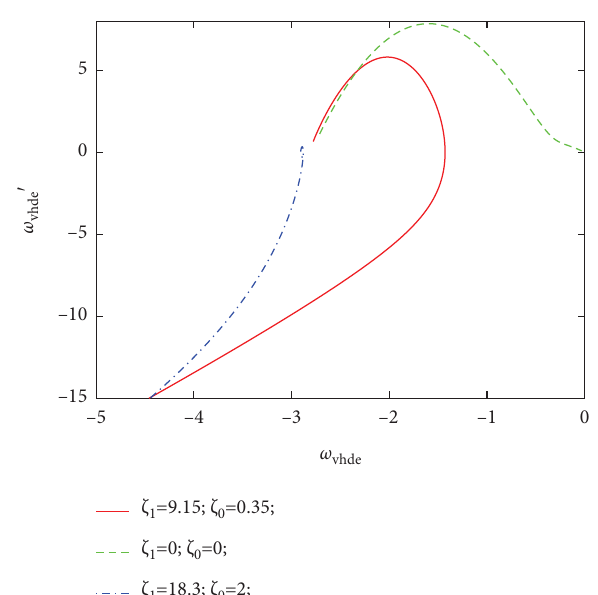
− ω ) for vhde vhde ′